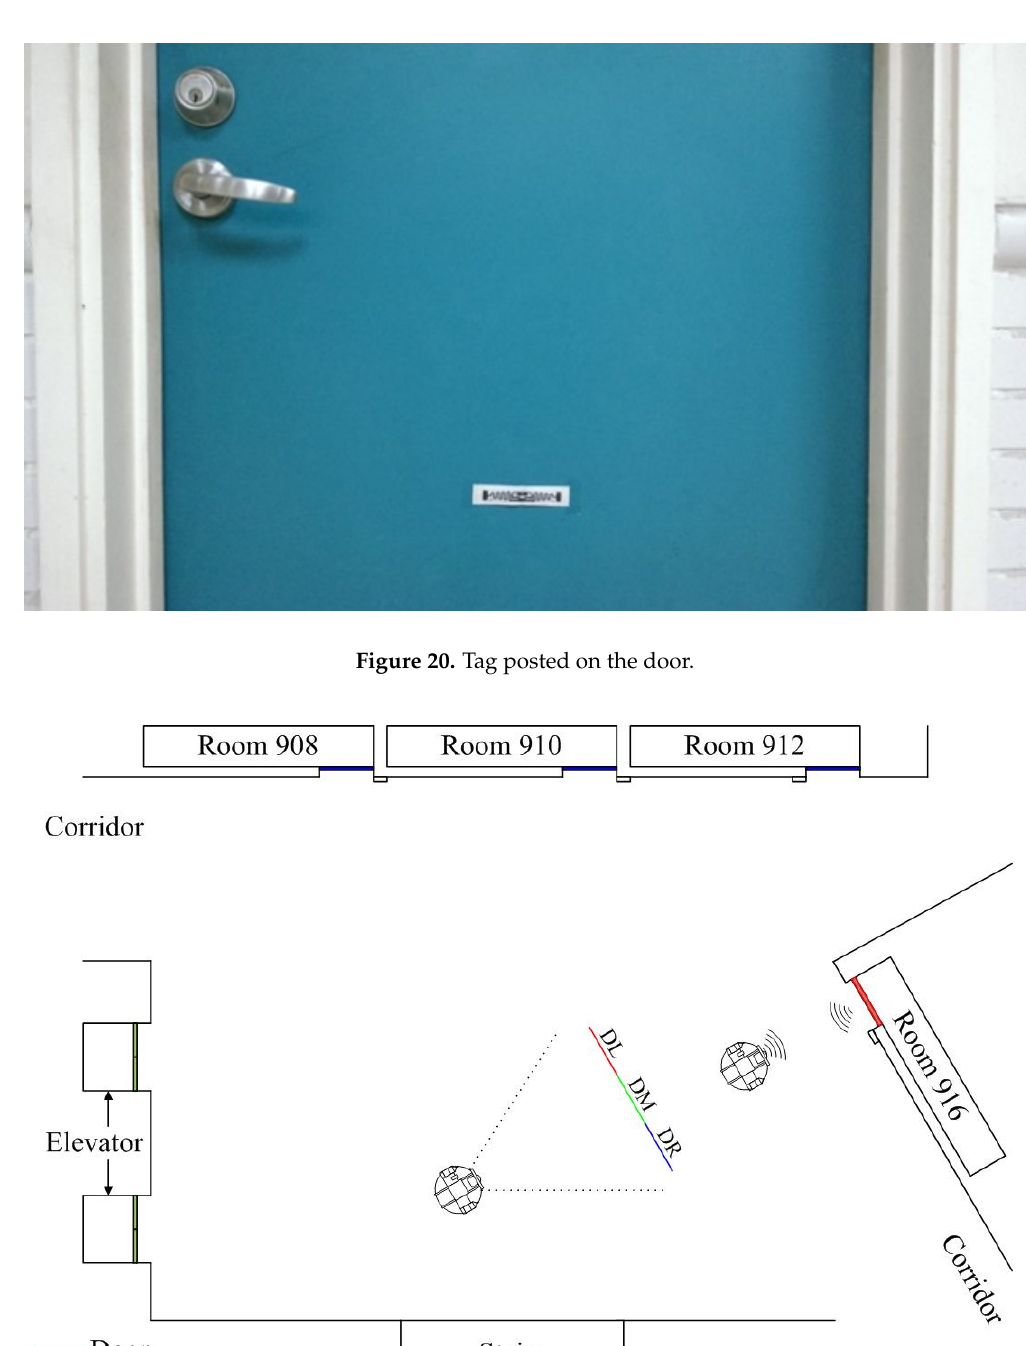
Figure 21. RFID verifies the destination at a specified distance.